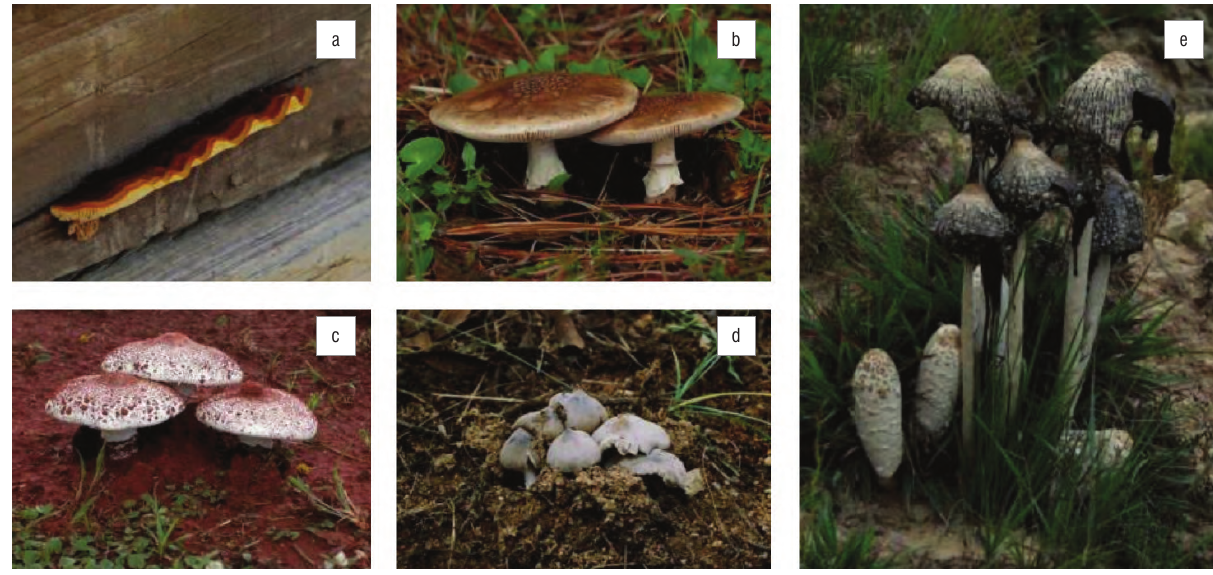
Photos: Wilhelm de Beer, University of Pretoria (reproduced with permission). South African fungal diversity is vast and largely unexplored. Mostly invisible, except when the fruiting bodies appear, fungi play critical roles in environmental processes such as lignocellulosic degradation by, for example (a) Gleophyllum spp.; as mycorrhizal symbionts of trees, including (b) Amanita spp.; (c,d) as Termitomyces symbionts of termites; and as saprophytes, for example (e) Coprinus spp., that break down dead plant tissues; and in many other processes including as causal agents in plant and animal